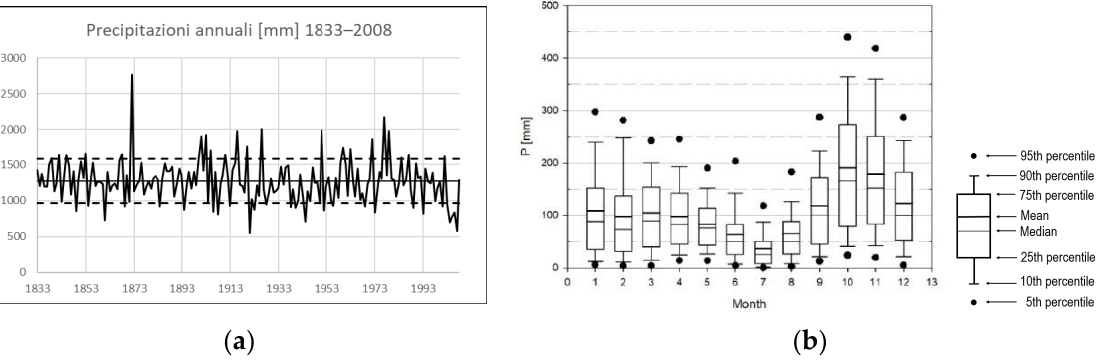
Figure 1. ( a ) Quasi-bicentennial daily rainfall record as observed at the meteorological station of Genova Università, with continuous and dashed lines indicating the mean plus/minus the standard deviation of the whole series, respectively; ( b ) seasonal variability of monthly precipitation. Boxes and whiskers encompass the central 50% and 80% of the dataset, respectively, while dots indicate the 5th and 95th percentiles of their non-parametric distribution. The mean and median values are depicted with thick and thin horizontal lines, respectively.